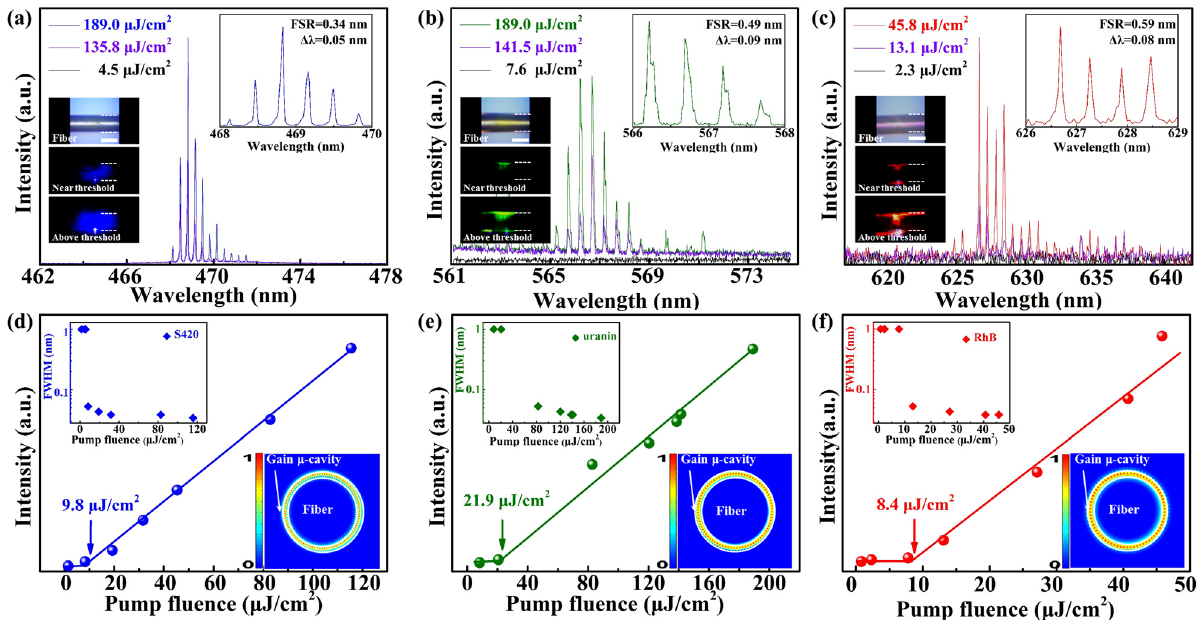
Figure 2: The RGB WGM lasing spectra. (a – c)ThespectraofWGMlasingwiththeexcitationontheblue-emitting,green-emittingandred-emittingcavity.Bottomleftillustrationisthe optical pictures under different pump power (light and dark field). Top right is the enlarged spectrum, respectively. Scale bars: 100 μ m. (d – f) The relationship between pump power density and output intensity, the threshold are 9.8 μ J/cm 2 , 21.9 μ J/cm 2 and 8.4 μ J/cm 2 marked by an arrow, respectively. Bottom right illustration is the simulated electric fi eld intensity in transverse cross-section. Top left illustration is the FWHM at different pump fl uence,